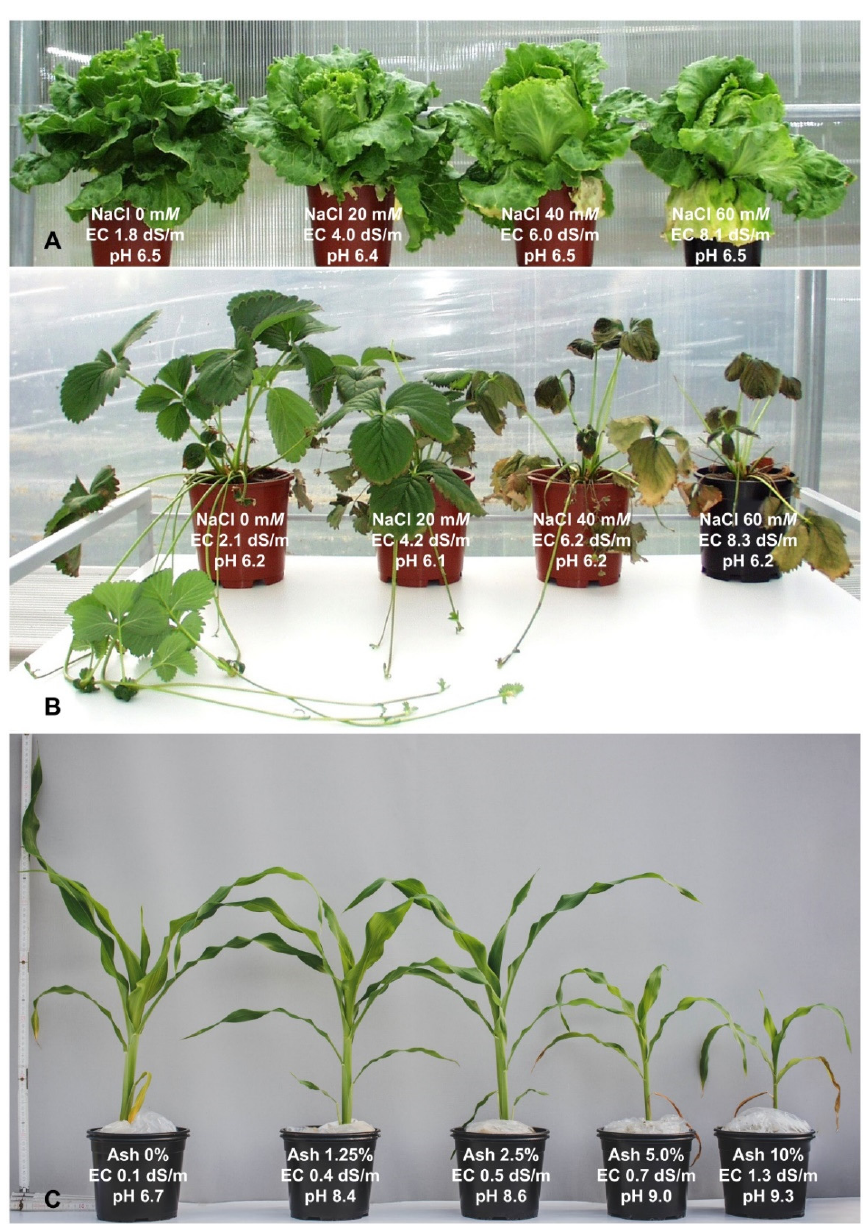
Figure 1. Vegetative and growth performances of lettuce ( A ) and strawberry ( B ) exposed to neutral salt stress (0–60 mM NaCl), and corn ( C ) exposed alkaline salt stress (0–10% wood-derived ash) with induced soil electrical conductivity (EC) and pH changes, after